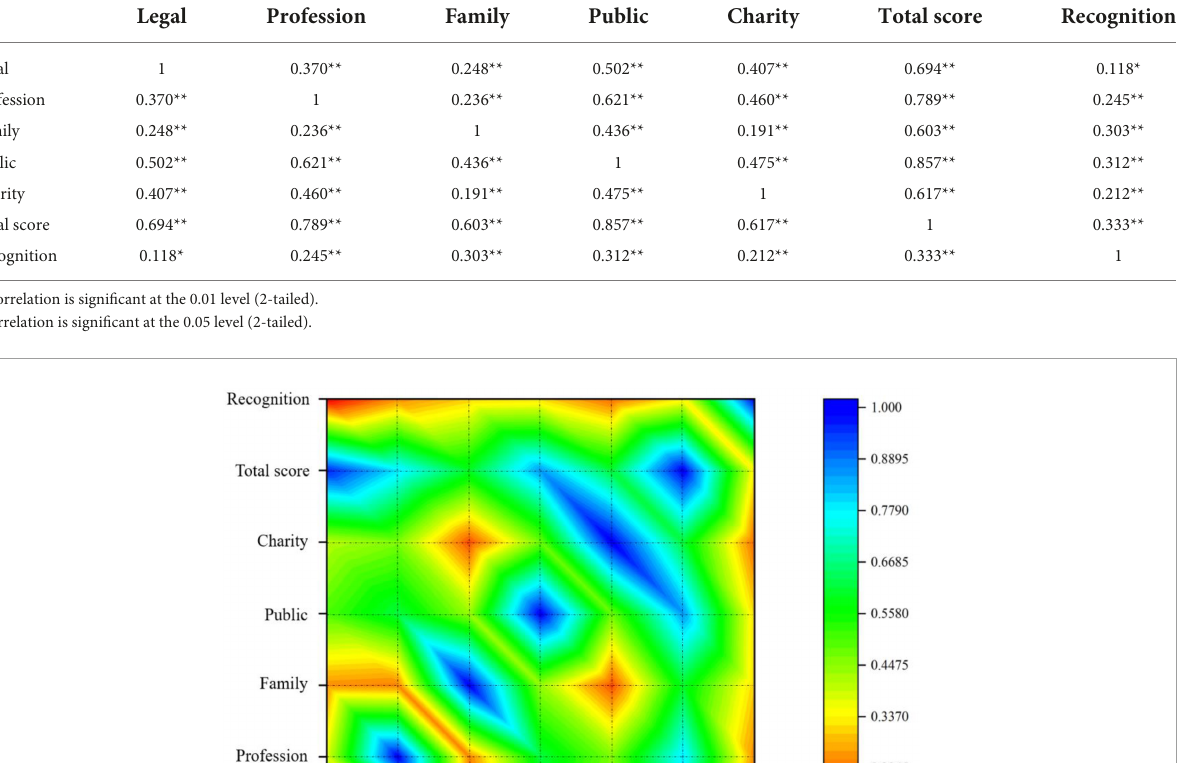
TABLE 3 Correlations.